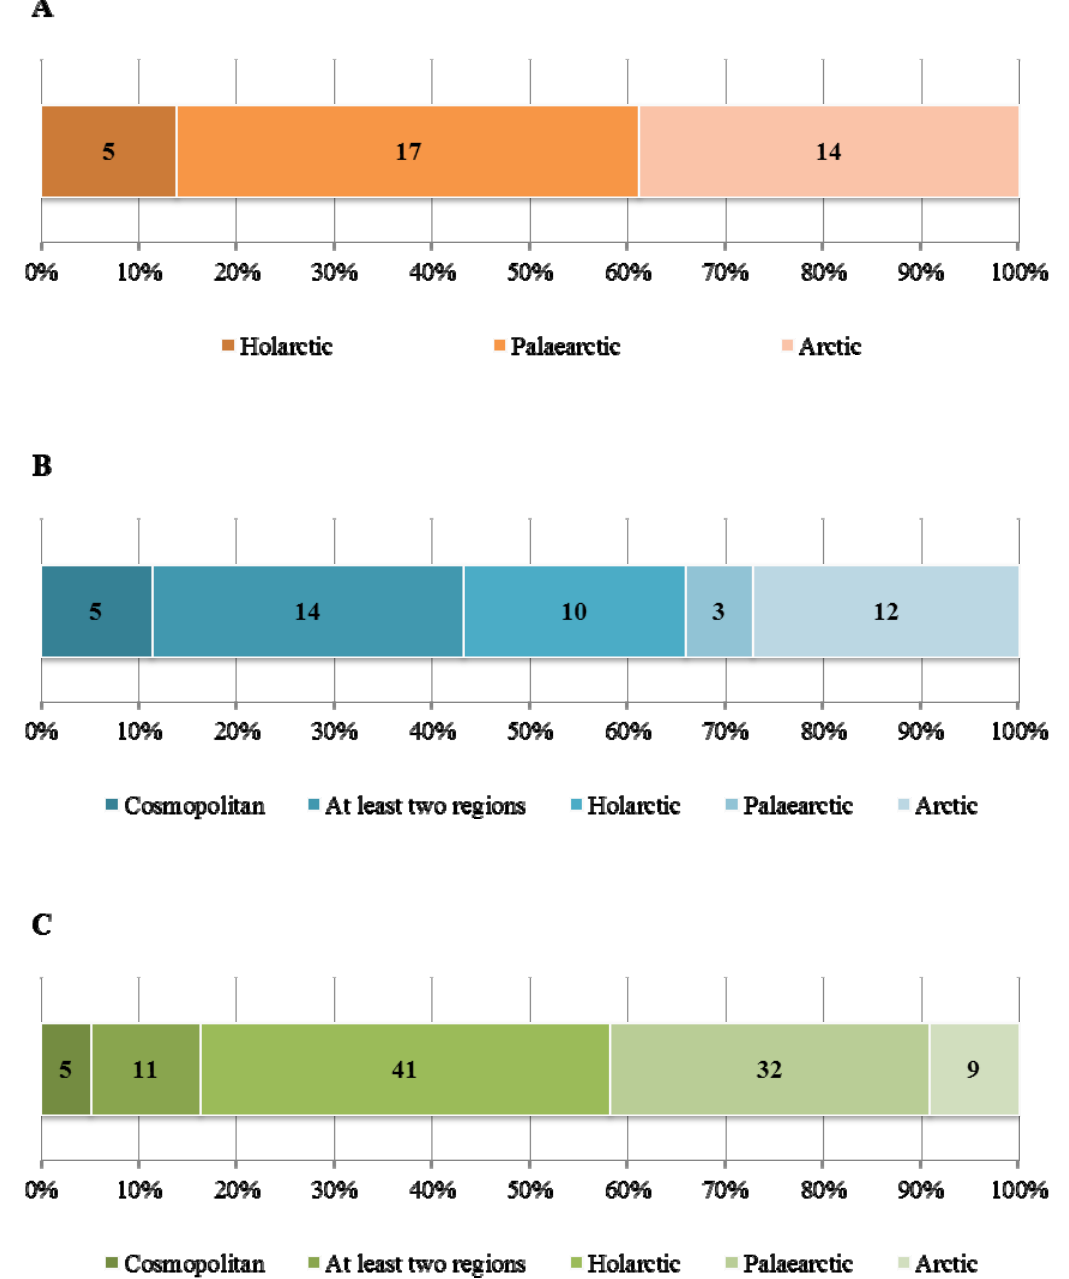
Figure 3. Distribution of mite species occurring in Svalbard: ( A ) Mesostigmata; ( B ) Trombidiformes; ( C ) Sarcoptiformes. No figure was made for the Ixodida, which are represented in Svalbard by one species with a distribution in “at least two regions” (see Table 1 for details).